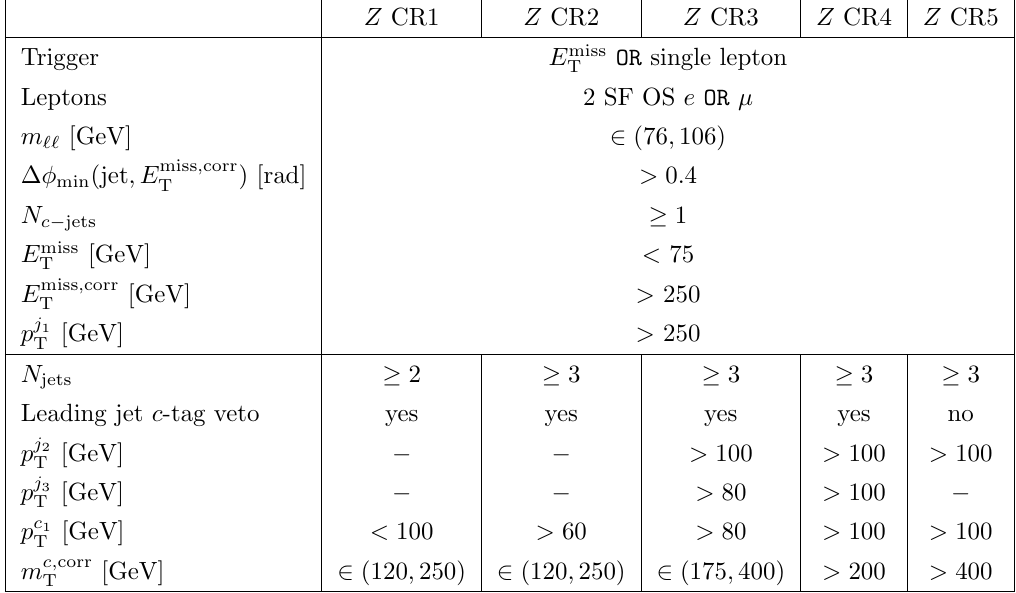
, p j 2 and p j 3 indicate the transverse momentum of the T T T is the transverse momentum of the c -jet with T